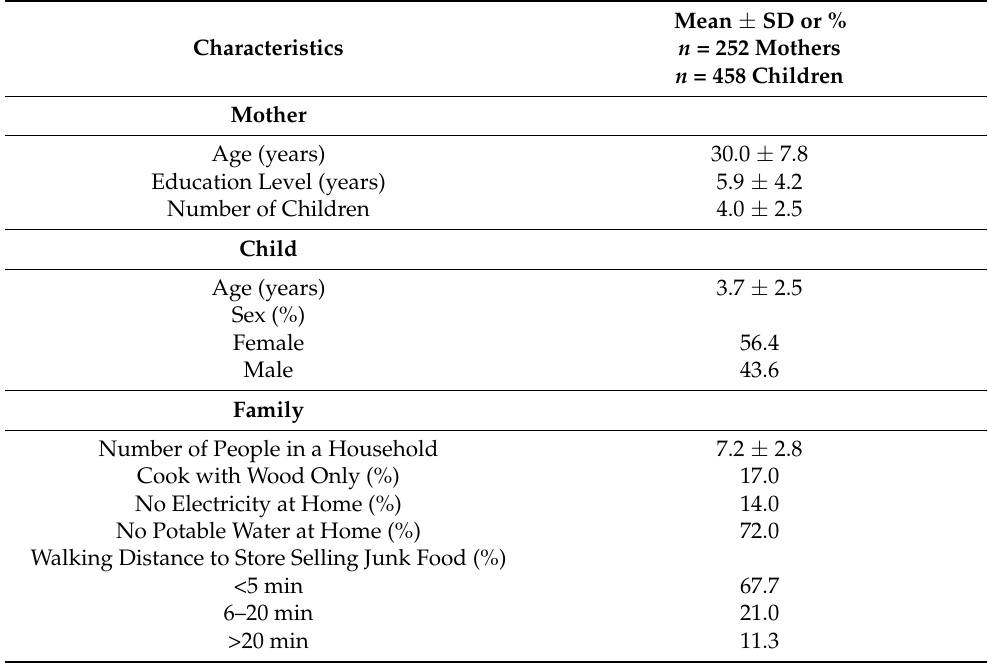
Table 1. Family Demographic